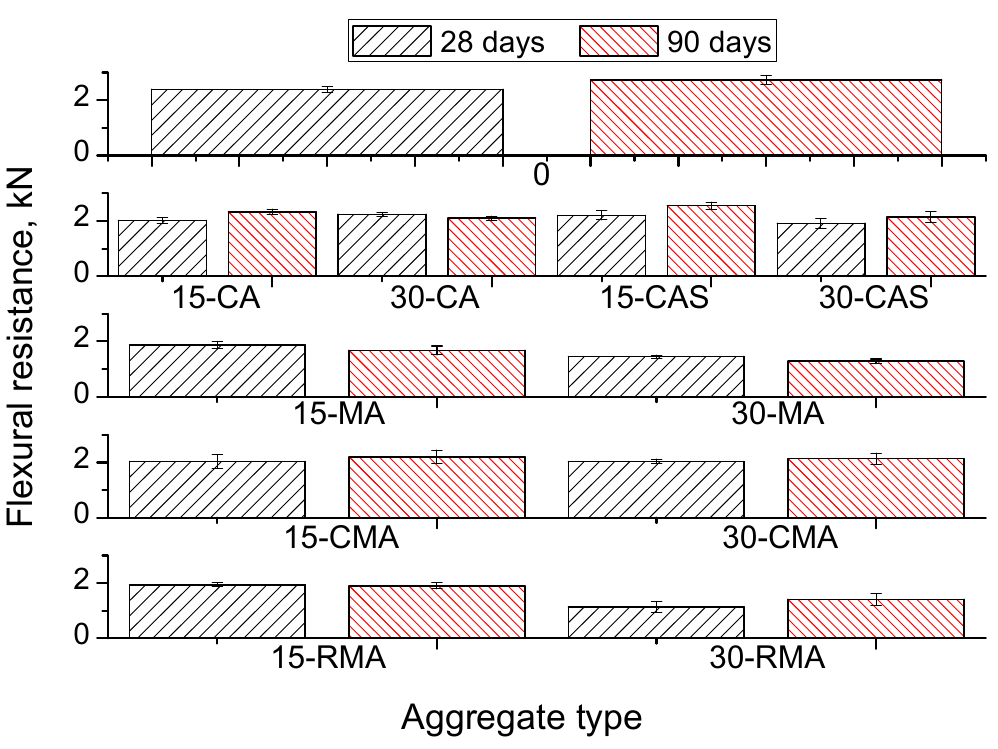
Figure 6. Results of flexural strength in hollow tiles.